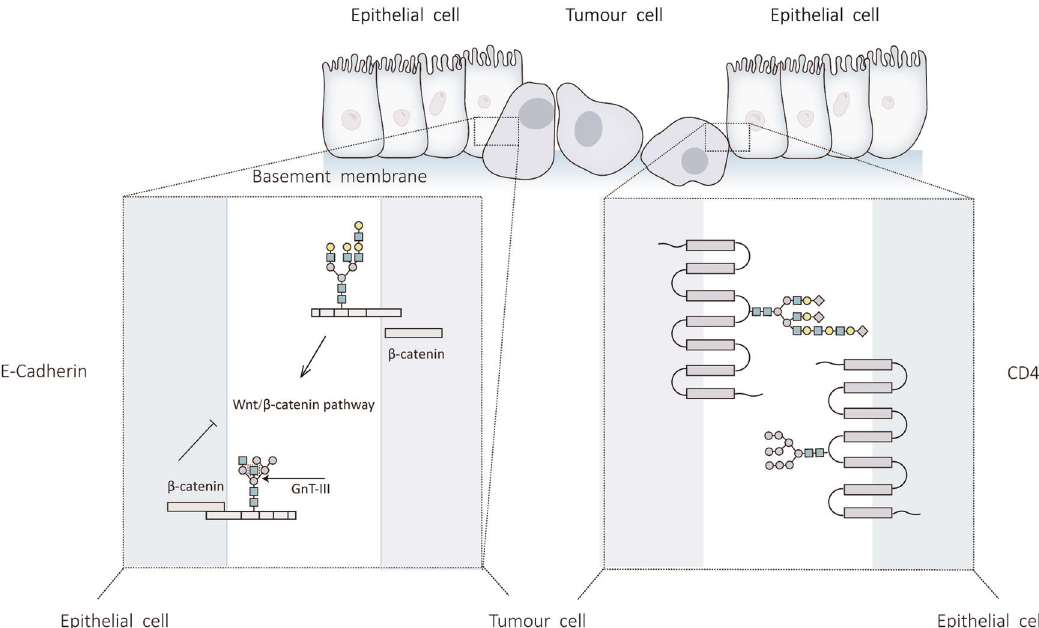
Fig. 3 Effect of N-glycosylation modi fi cation on EMT. A large body of experimental evidence shows that EMT is an indispensable part of the occurrence and development of liver cancer, which involves the abnormal N-glycosylation of related proteins. This diagram summarizes the abnormal N-glycosylation of associated proteins during EMT in liver